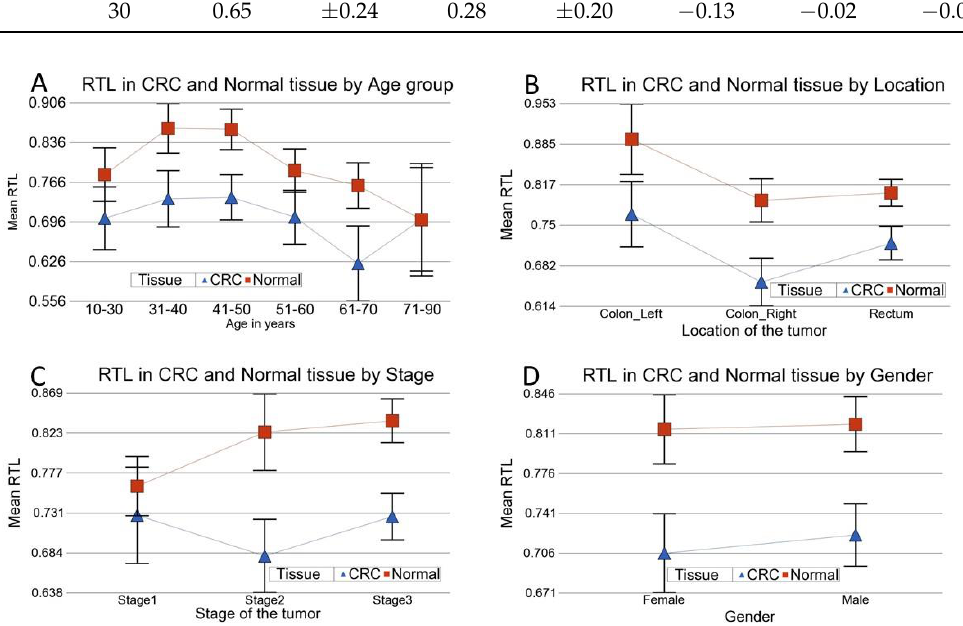
Figure 2. Comparison of RTL in CRC tissue (in blue) and corresponding normal tissue (in red) by age group ( A ), location of the tumor ( B ), tumor stage ( C ) and gender ( D ). Table 2. RTL in CRC and paired normal tissue.